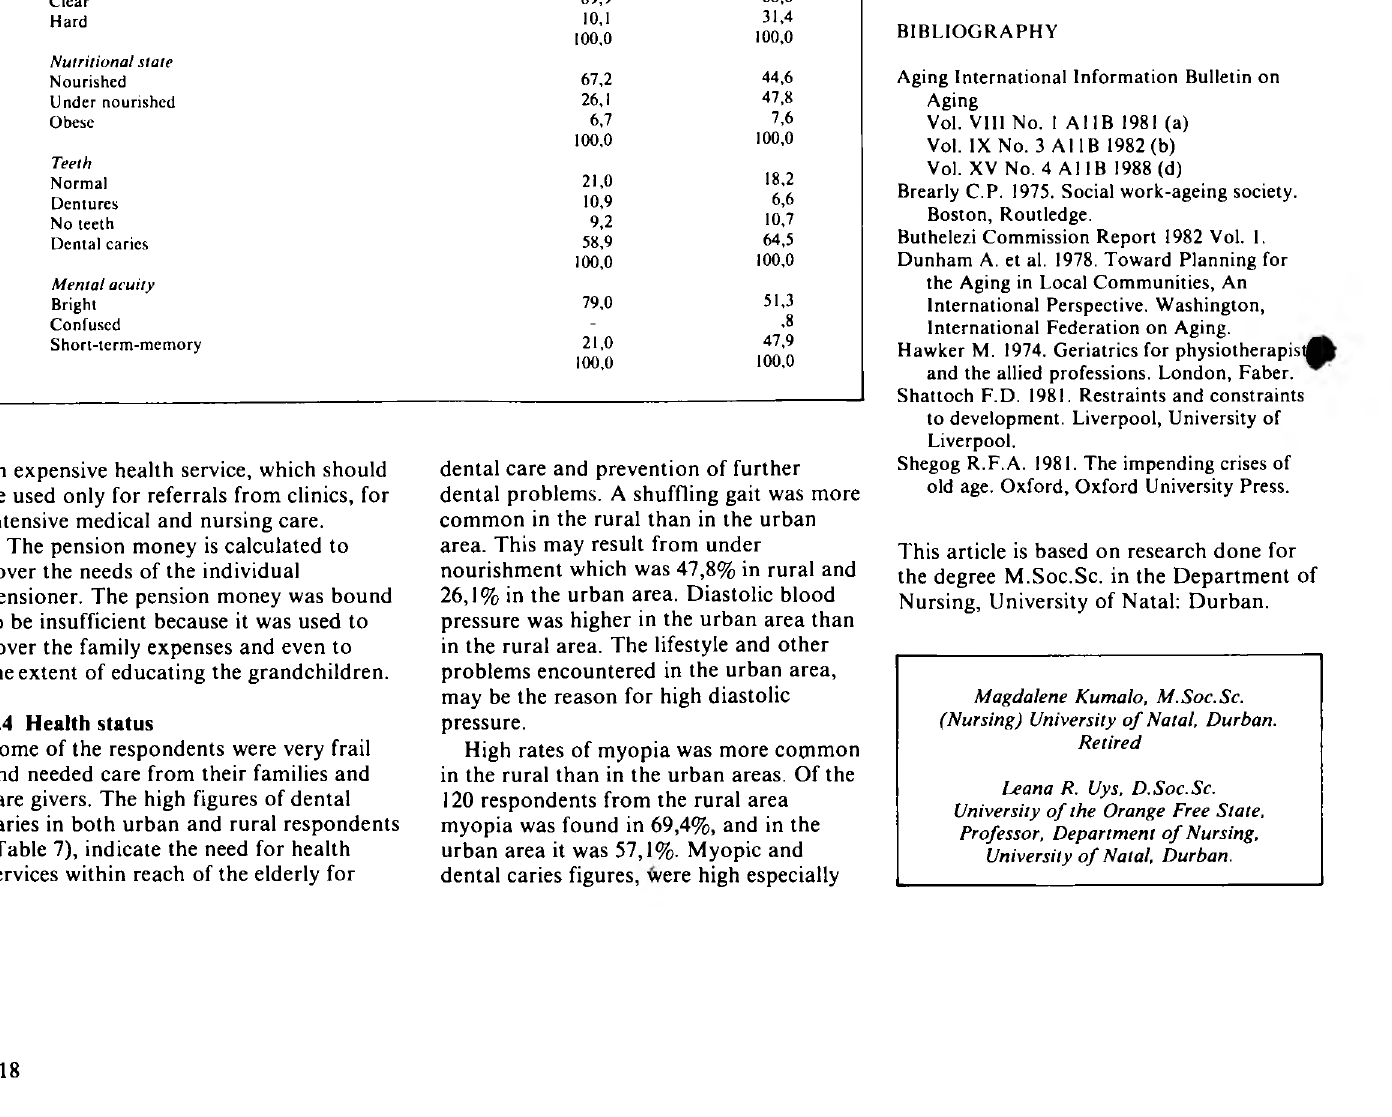
Percentage Urban Rural